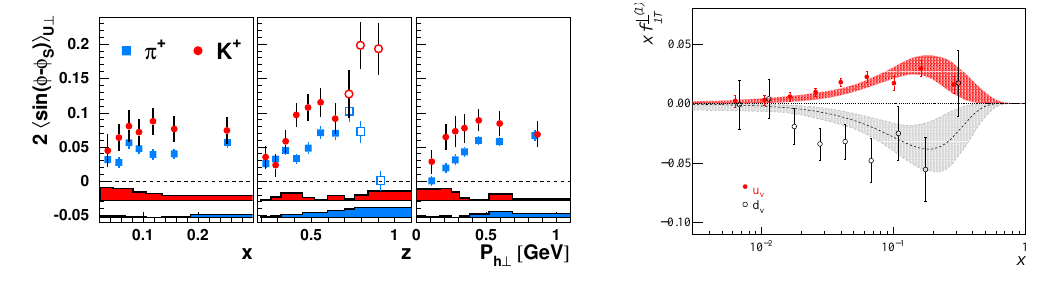
Fig. 11: Values of the first moment of the Sivers function for u (closed red dots) and d (open black Figure 13 . Comparison of Sivers SFA for positive pions (squares) and kaons (circles) presented dots) quarks from the P T / zM weighted-Sivers asymmetries for charged hadrons with z > 0 . 2. The curves and the uncertainty bands are the results of the fit of Ref. [23]. Figure 2: Left: Sivers asymmetries from HERMES SIDIS for positive pions and kaons either in bins of x , z , or P h . Data at large values of z , marked by open points in the z projection, are ⊥ not included in the other projections. Systematic uncertainties are given as bands, not including the [ 15 ] . Right: first Sivers moments for valence u - and d -quarks from COMPASS p - T additional scale uncertainty of 7.3% due to the precision of the target-polarization determination. weighted asymmetries in SIDIS [ 16 ] , together with a fit to SIDIS world data [ 17 ] . observed are not driven merely by exclusive ρ 0 electroproduction. 960